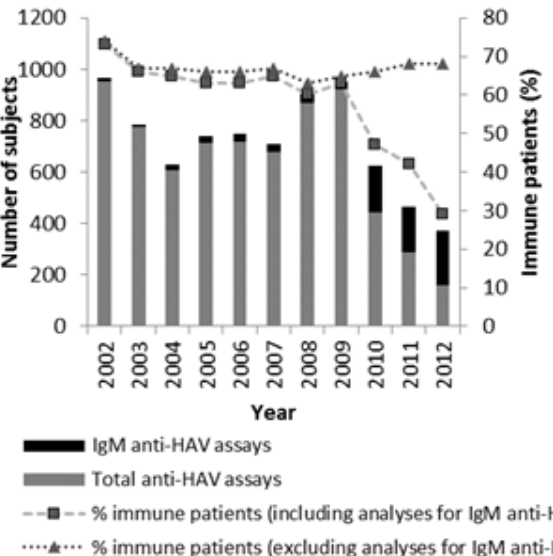
Figure 3. Samples classification during the study period